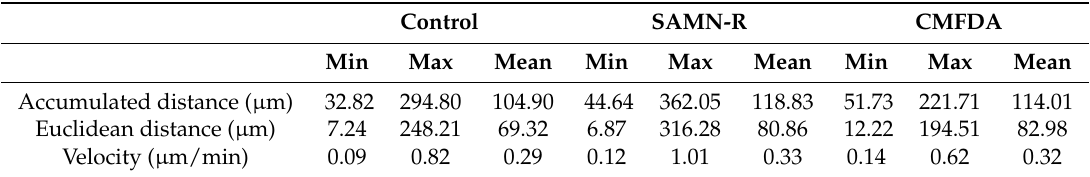
Table 4. Migration of hMSCs in Patient 2 from 30 cells of control, CMFDA-labelled, and SAMN-R treatment groups. The velocity, accumulated, and Euclidean distance values for a six-hour period are shown.